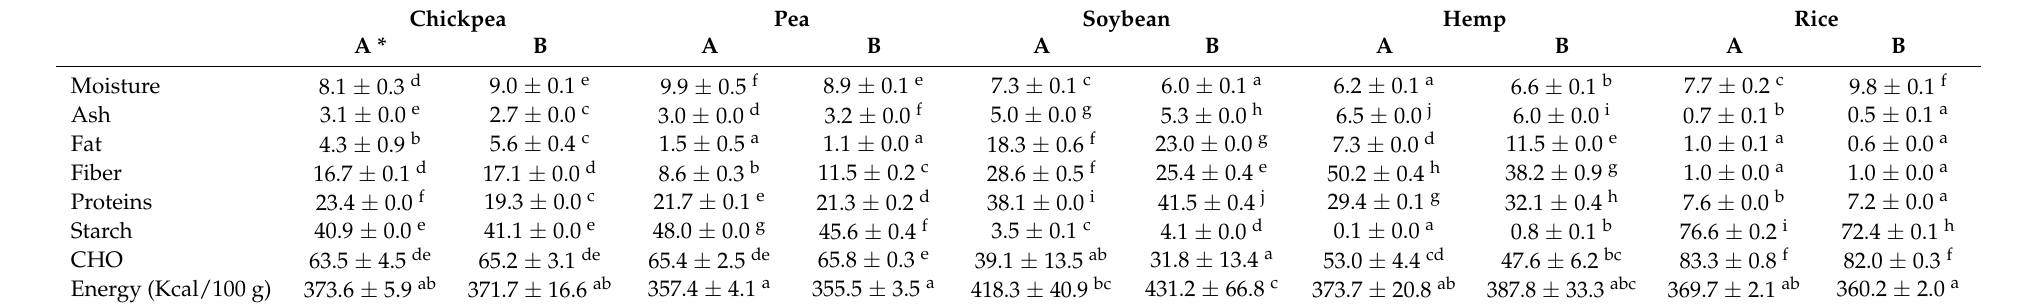
Table 1. The proximate composition (g/100 g fresh weight) of different flours. Data presented as means ± standard deviation from triplicate analysis.